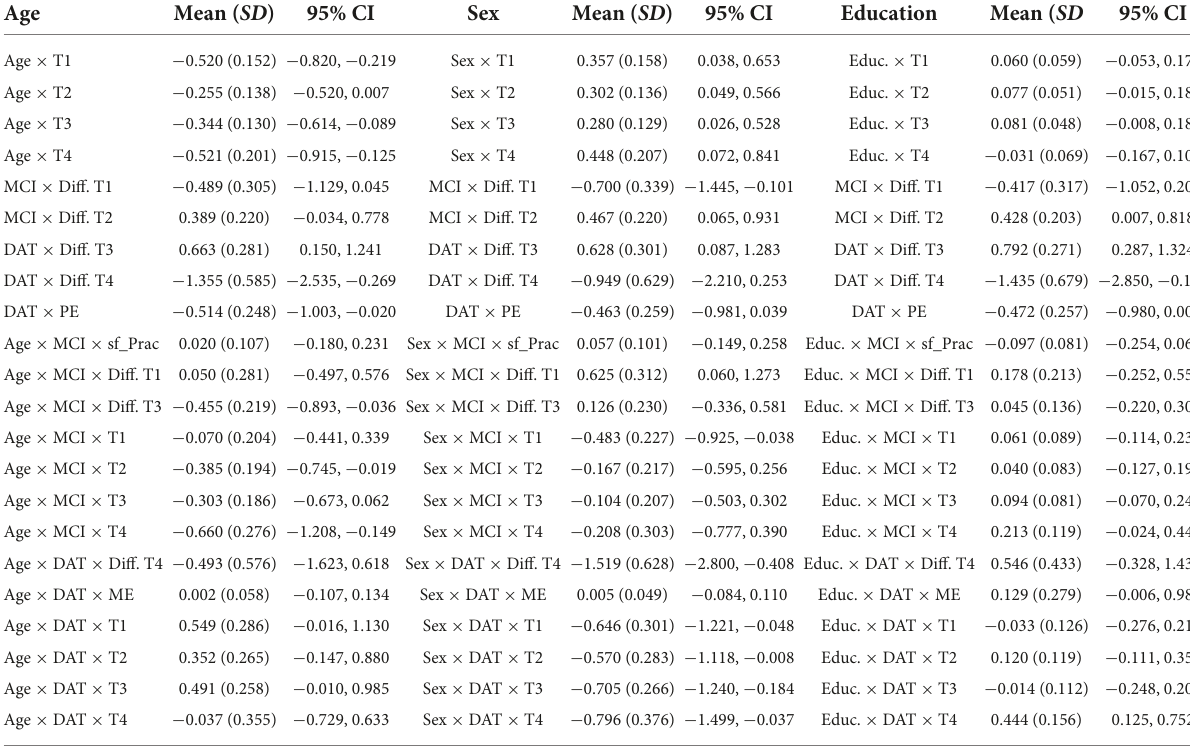
TABLE 5 Significant and trending covariate effects and interactions with diagnostic groups in sensitivity models of age, sex and